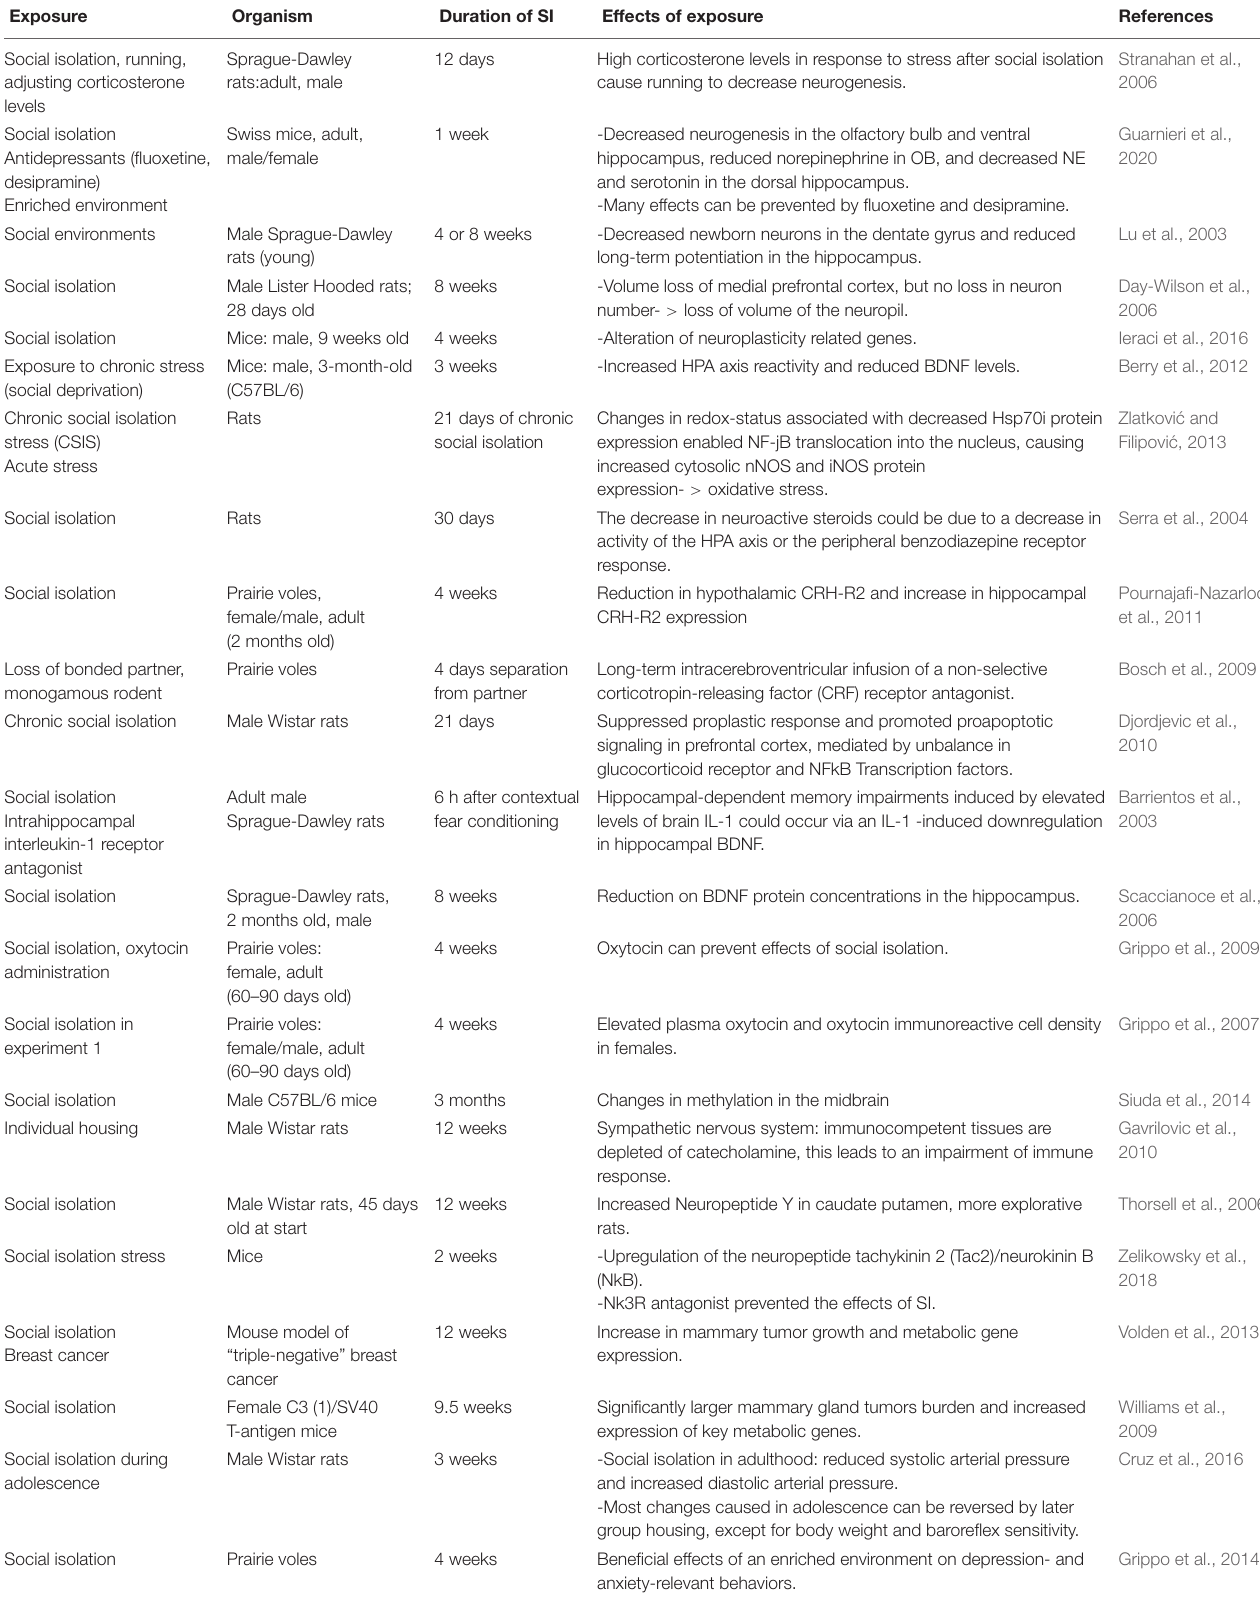
TABLE 2 | Effects of social isolation (SI) in animal